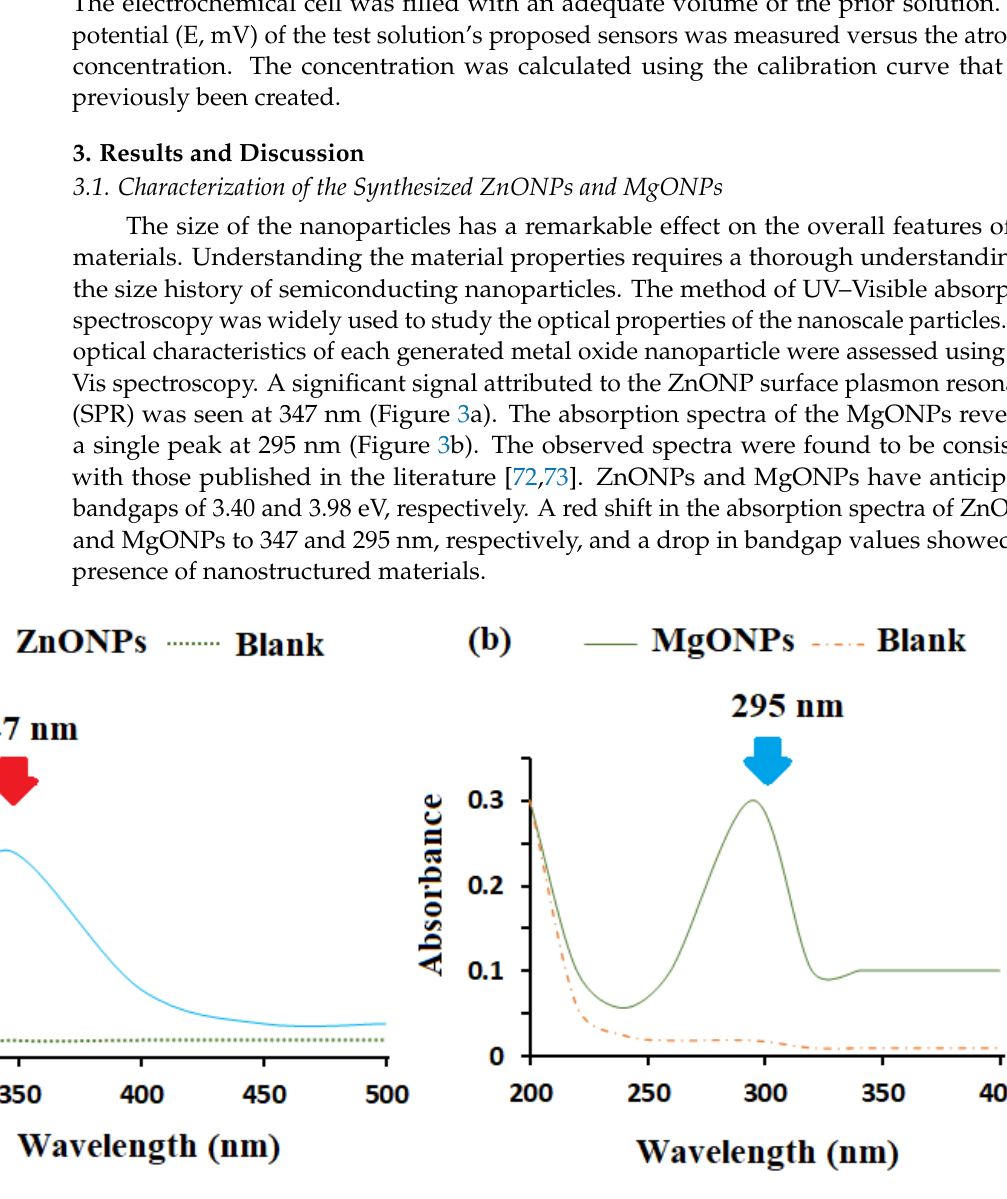
sponded to the water’s O–H stretching vibration. At 2370 cm − 1 , the absorption band cor- responded to a strong O = C = O carbon dioxide stretching vibration. Bands at 1020, 965, 720, 520, and 466 cm − 1 , which correspond to the hexagonal crystalline Zn–O nanoparticles, were observed from 1000 to 400 cm − 1 (Figure 4a). FTIR in the 400–4400 cm –1 range was used to investigate MgONPs. At 3700, 3428, 1513, 1150, 876, 564, and 447 cm –1 , different absorption bands for MgONPs were detected. At 3700 and 3429 cm –1 , the stretching vibration of the O–H bond was measured in two bands. CO 2 stretching vibration as a result of ambient carbon dioxide adsorption was blamed for the weak band at 2360 cm –1 . The existence of an O–H stretching mode of water was shown by two newly found absorption bands about 1512 and 1400 cm –1 . The high peak of magnesium hydroxide (Mg– OH) was discovered at 876 cm –1 . The detected peaks, which appeared from 568 to 447 cm –1 , confirmed the creation of Mg–O stretching vibra- tions (Figure 4b). Figure 4. The FTIR spectra of the ( a ) ZnONPs and ( b ) MgONPs measured at wavenumber in the range of 500–4500 cm −1 .